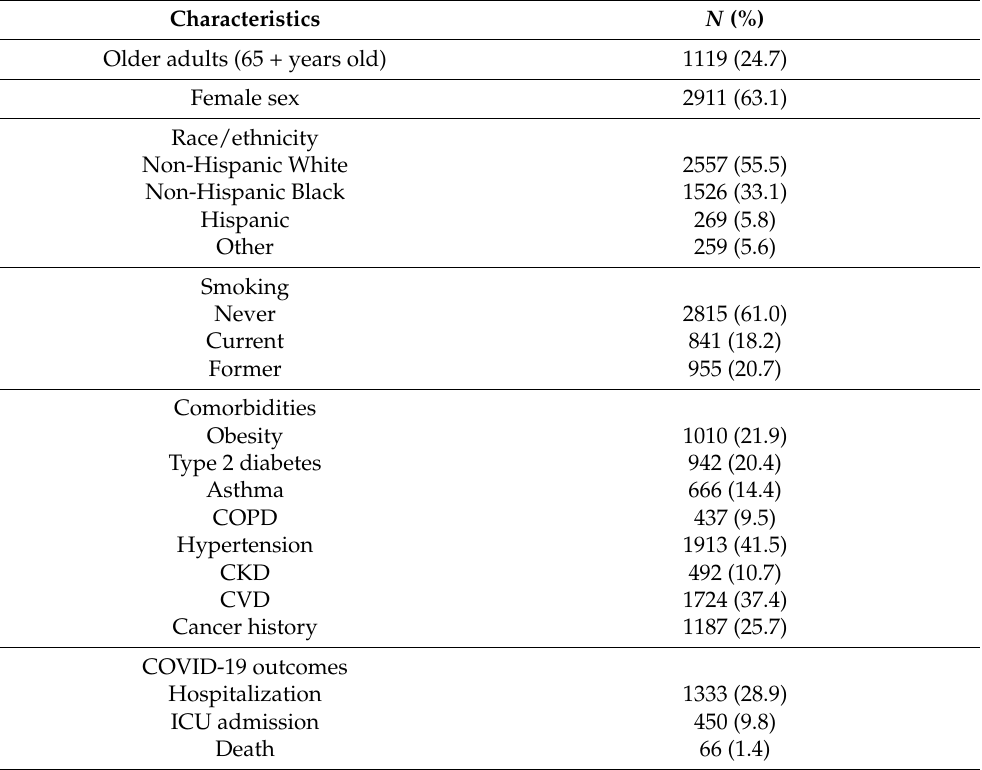
Table 1. Overall characteristics of study participants ( N = 4611).